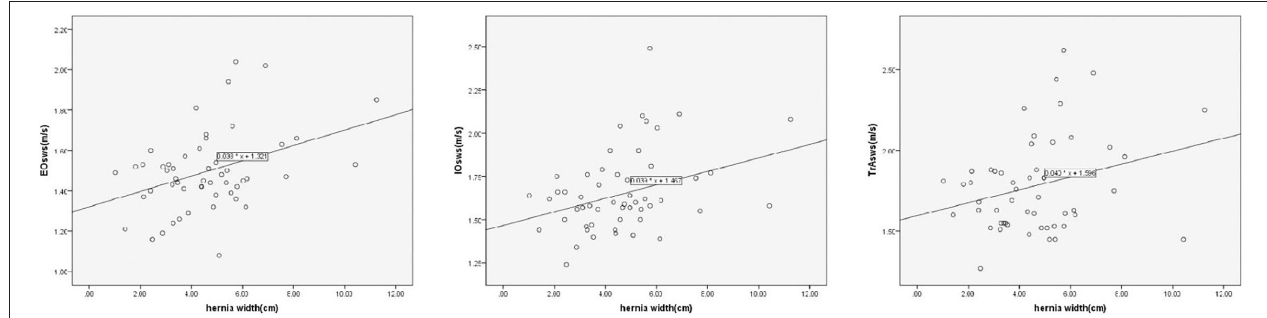
FIGURE 6 | Linear correlation analysis shows significantly positive correlation between hernia width and the mean SWS value of the EO, IO, and TrA ( p = 0.004, 0.005, and 0.043,